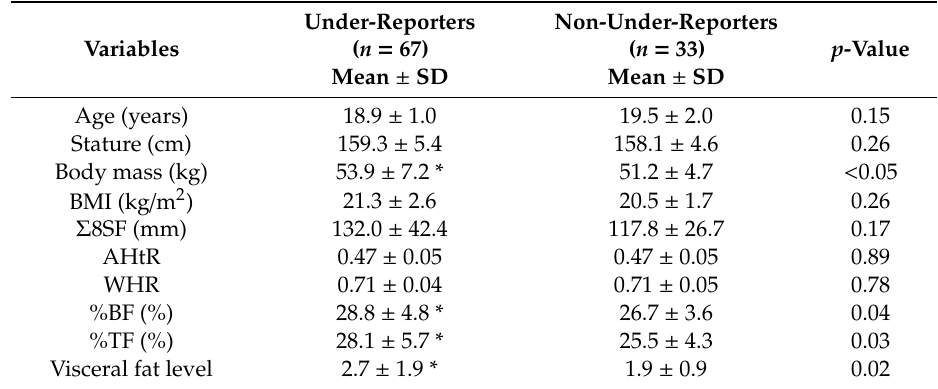
Table 3. Di ff erences in demographic characteristics between non-under-reporters and suspected